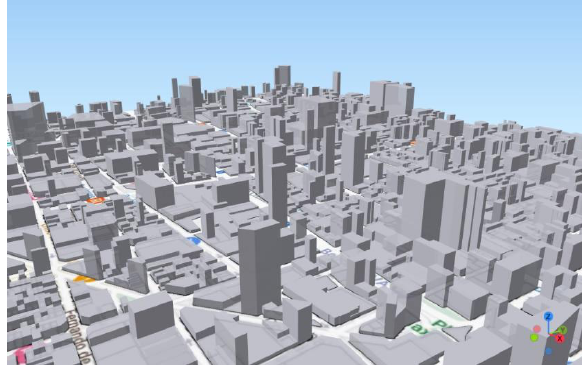
Figure 3. 3D model of Mexico City.